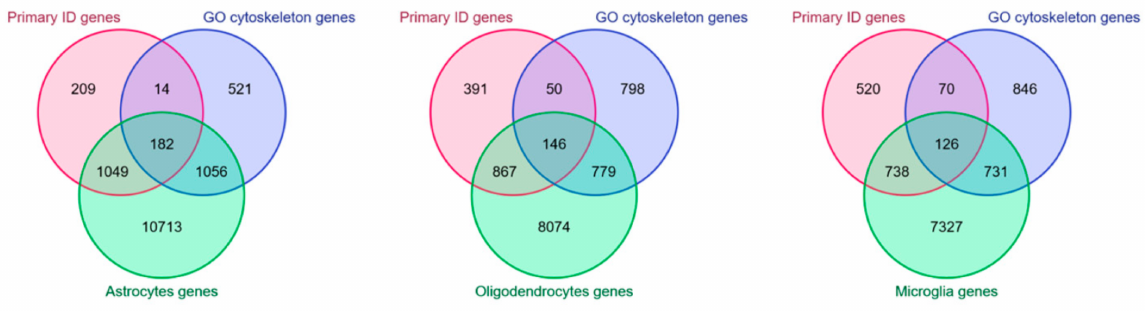
Figure 3. Cytoskeleton-related ID gene expression in non-neuronal cells. Venn diagrams created with the multiple list comparator tool by molbiotools [345] showing the intersections between the lists of primary ID genes reported in the SysID database (red) [1], genes associated to the GO terms [12,13] “regulation of GTPase activity” and “cytoskeleton organization” (blue), and genes expressed in astrocytes (on the left), oligodendrocytes (at the center), and microglia (on the right) (green). The list of genes expressed in non-neuronal cell types was obtained from an RNA-seq dataset